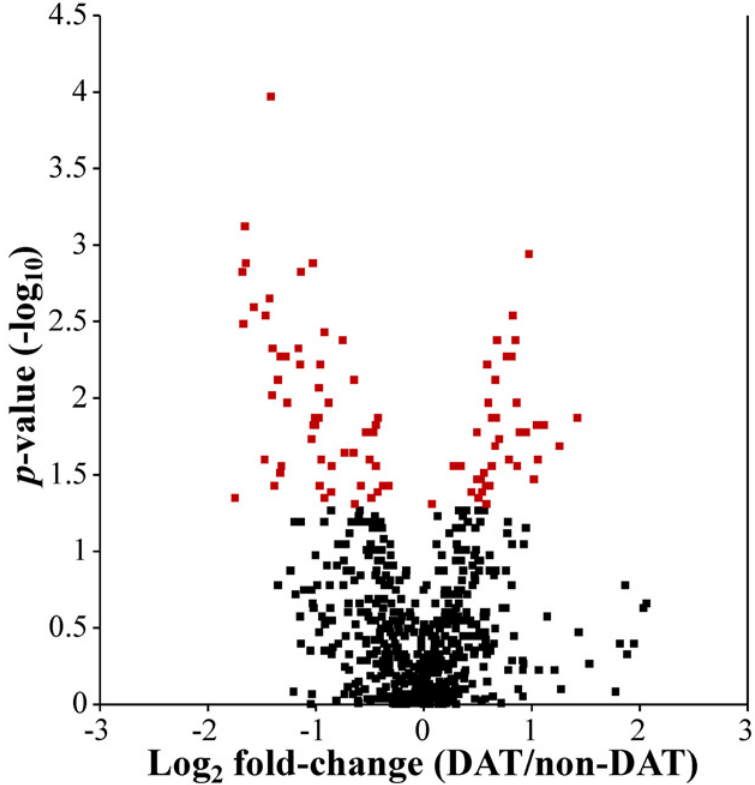
Fig 1. Volcano plot of all 618 spots in the training set. Spot intensities were compared between chronic DAT and non-DAT samples using a Wilcoxon rank sum test and the-log 10 p -value and log 2 fold-change (DAT/ non-DAT) values were used to generate a volcano plot. Red squares indicate spots with a p < 0.05 (n =